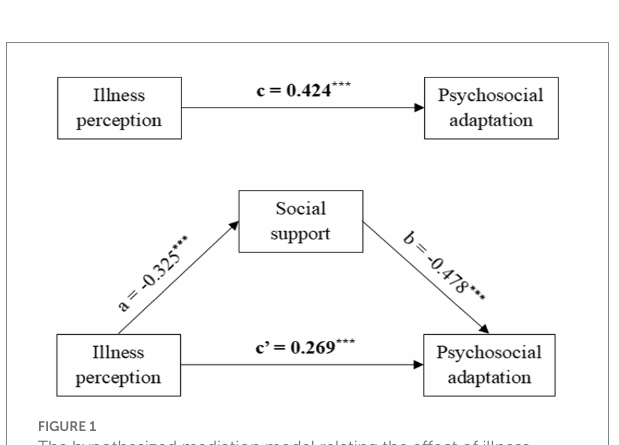
FIGURE 1 The hypothesized mediation model relating the effect of illness perception on physcosocial adoptation through social